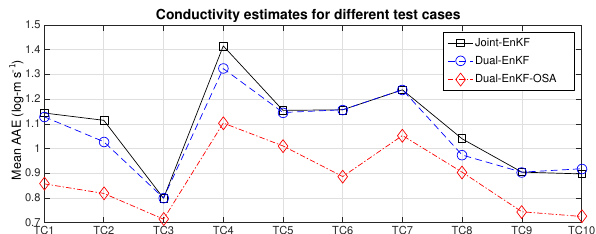
Figure 12. Performance of the joint/dual EnKF and the proposed dual EnKF OSA schemes in 10 different test cases (TC1, TC2, etc.). Mean AAE of the conductivity estimates are displayed. These re- sults are obtained with 100 members, 3 days of sampling period, nine observation wells, and 0.10m as measurement